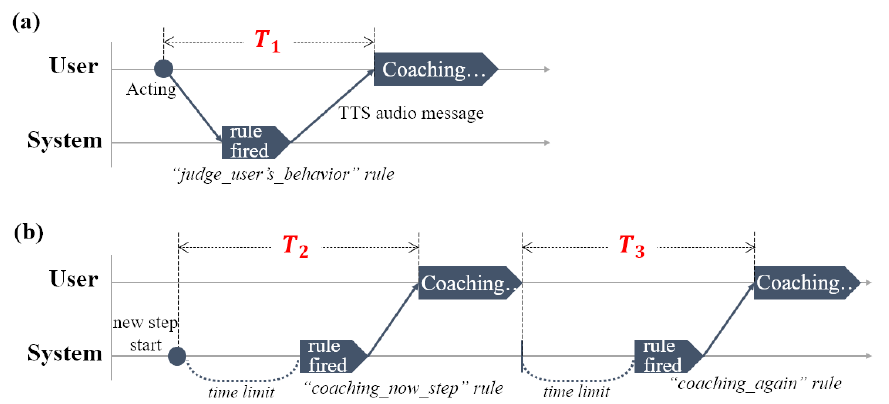
Figure 17. Coaching situations for the rules ( a ) “judge_user’s_behavior” ( b ) “coaching_now_step” and “coaching_again”.